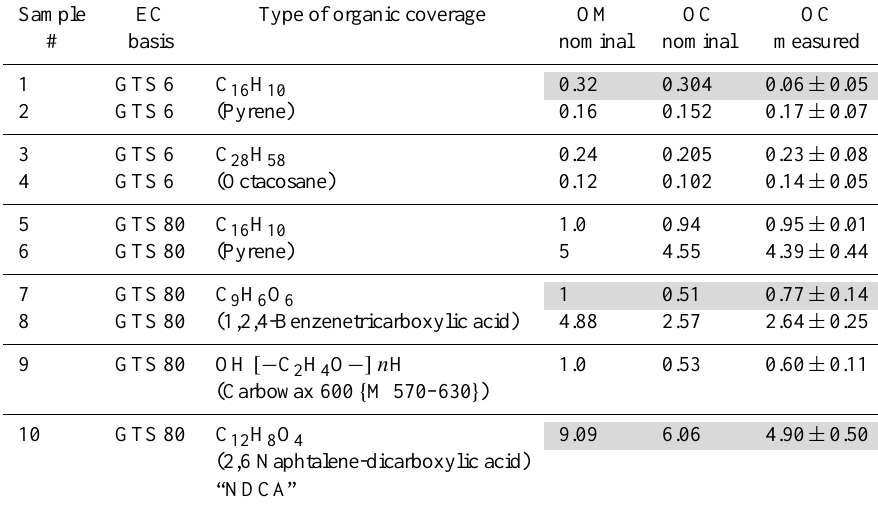
Table 1. Soot reference materials: EC basic and nominal organic matter (OM), organic carbon (OC), nominal and derived by the thermo/optical technique, wt%. Shaded cells indicate differences between the nominal and measured OC that are found to be outside the estimated